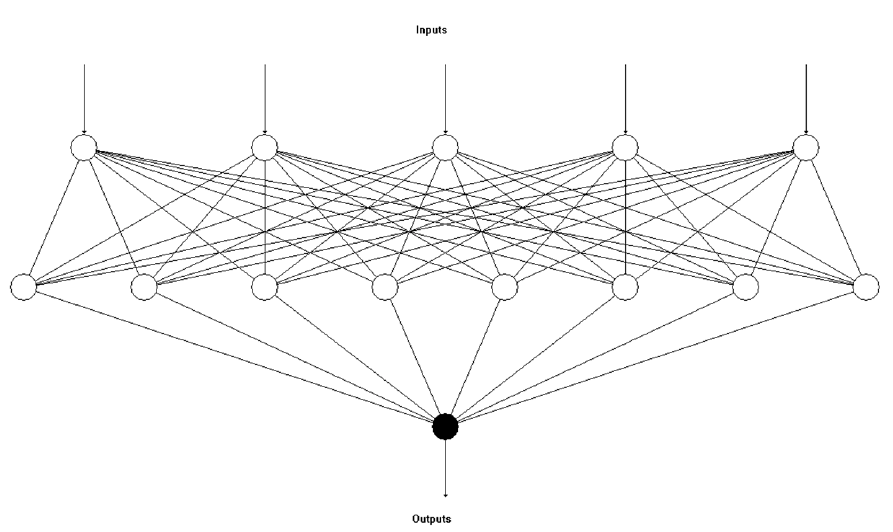
Figure 5. Final artificial neural network (ANN) architecture for predicting compressive strength of concrete.